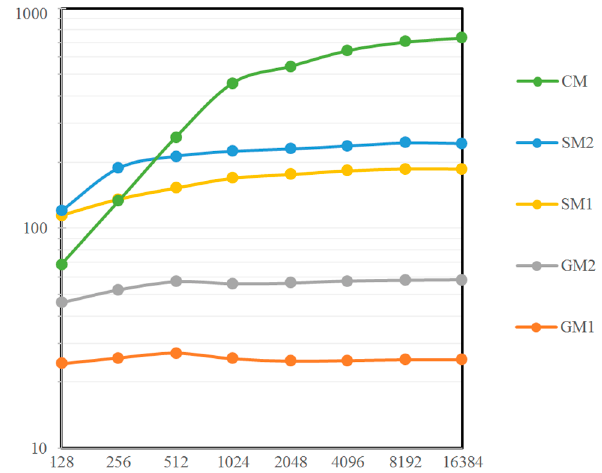
Figure 9. Logarithmic representation relating the computation acceleration factor w.r.t. basic CPU implementation (vertical) for different batch sizes (horizontal) of the different GPU implementations of the NN with {16, 32|16|8, 4} topology.